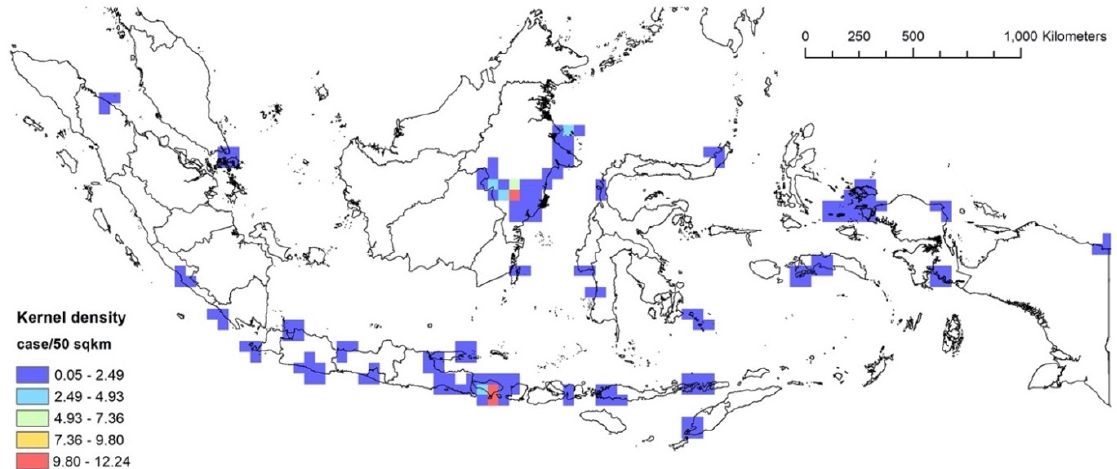
Figure 6. The kernel density analysis of the 1995–2011 stranding events based on the number of cases.